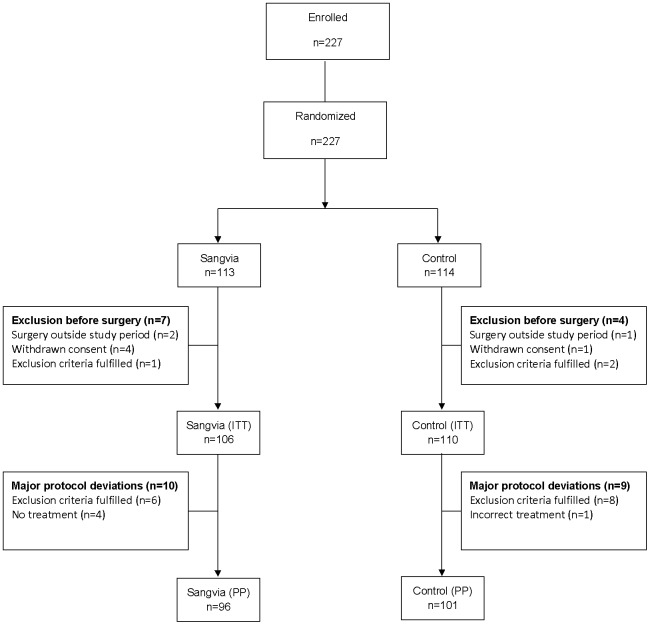
Study patient flow and definition of analysis sets.